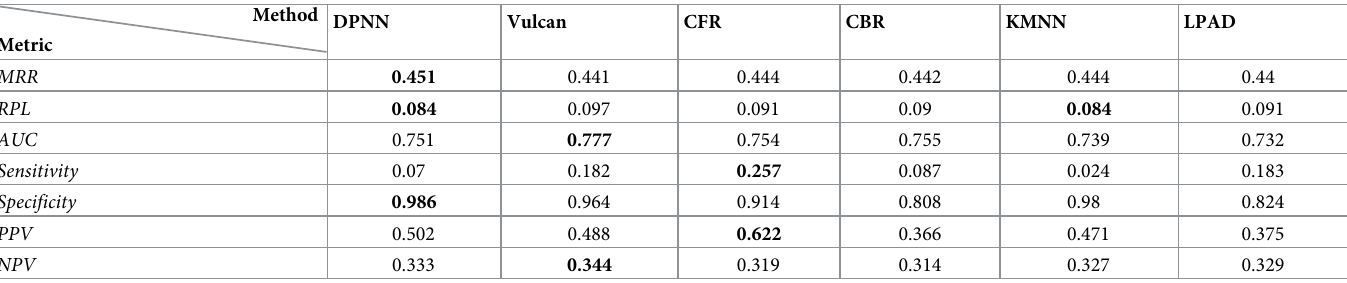
Table 3. Experiment 1 (synthetic data): Median scores for each evaluated method (column) and evaluation metric (row). For all metrics ecepts RPL , the higher the bet- ter. For RPL , the lower the better. Results in bold are significantly superior to non-bold results, p � 0.01.